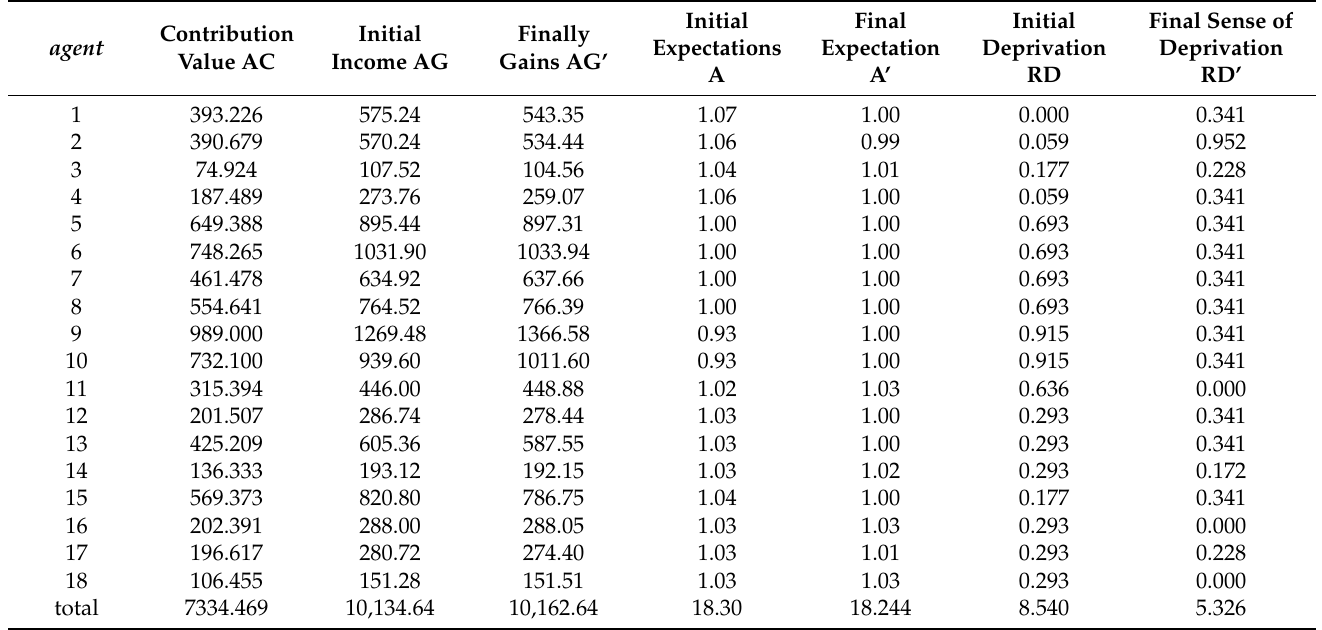
Table 3. Results of benefit